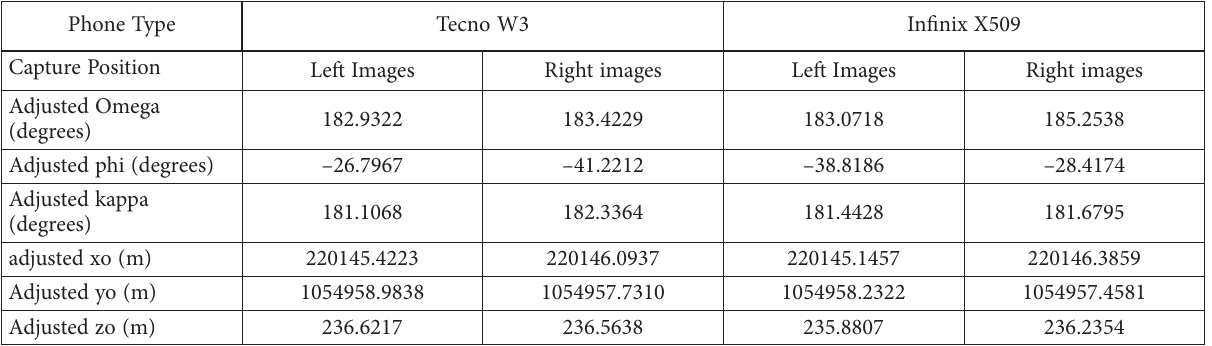
Table 2. Adjusted exterior orientation